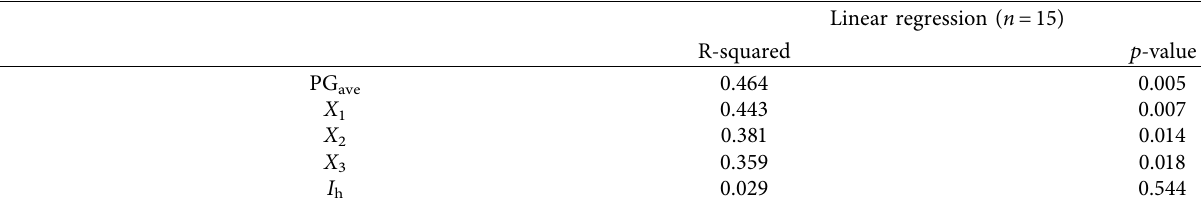
Table 9: Linear correlation between rut depth and independent variables.